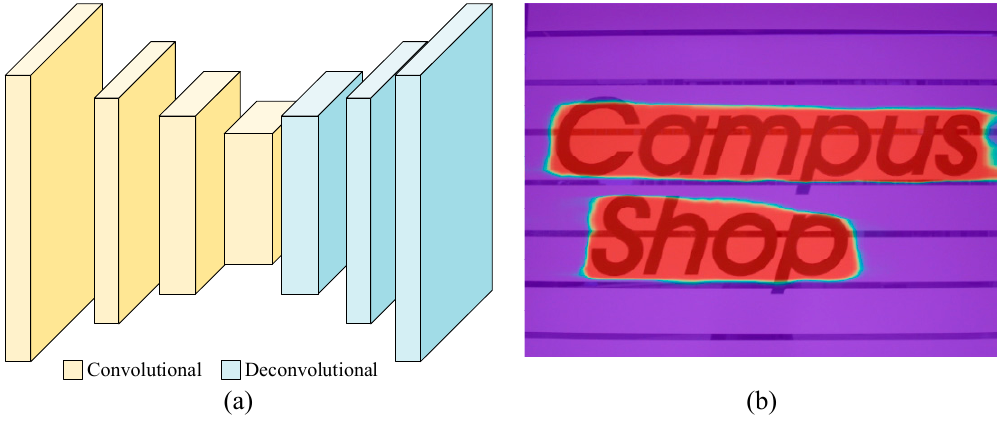
Figure 2. ( a ) Fully convolutional network (FCN) architecture. Including convolutional and deconvolution layers. ( b ) Overlay of the input image and FCN processing results.